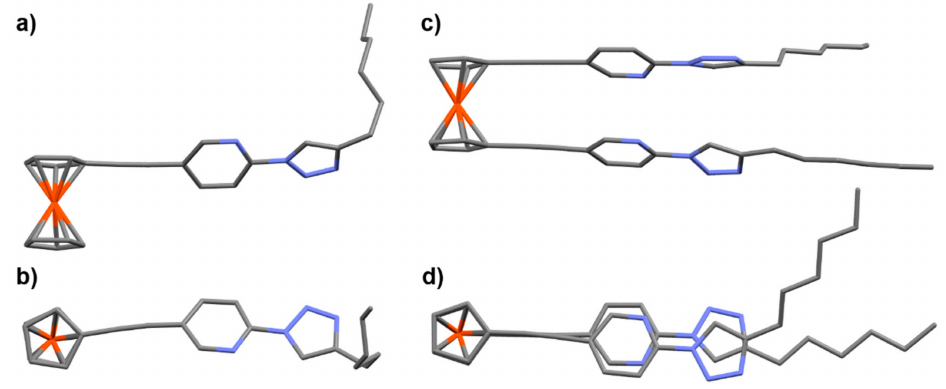
Figure 3. Depiction of the solid state structures of L2 and L4 ; ( a ) L2 side view, ( b ) L2 top view, ( c ) L4 side view, ( d ) L4 top view. Hydrogen atoms omitted for